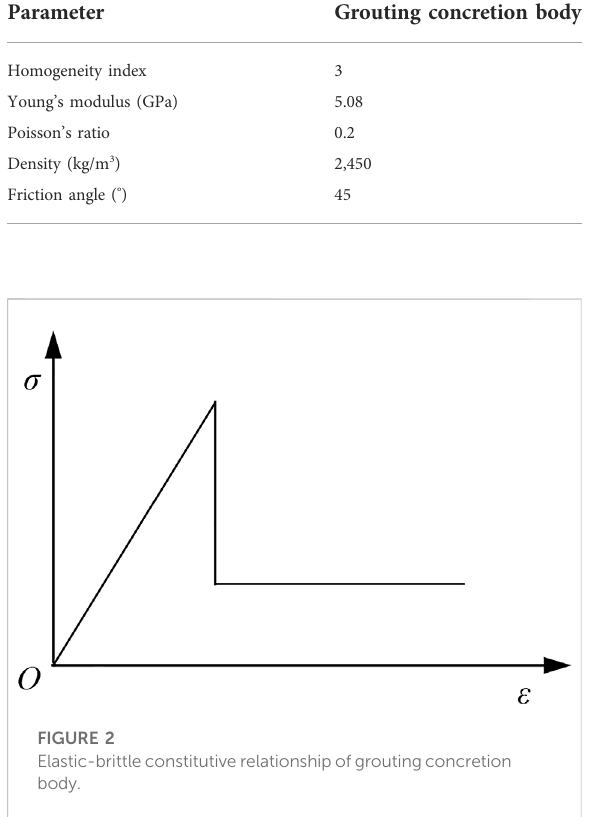
FIGURE 2 Elastic-brittleconstitutiverelationshipofgroutingconcretion